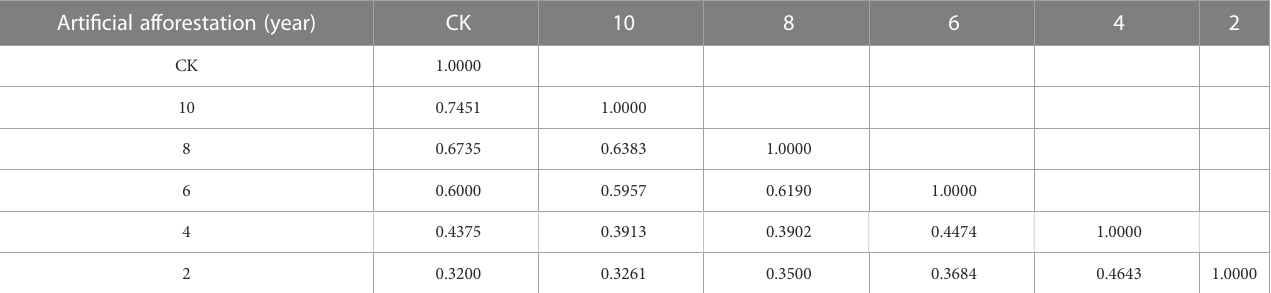
TABLE 4 Similarity coef fi cient of grassland plant community with different years of arti fi cial afforestation in Maxian Mountain of the Loess Plateau. Arti fi cial afforestation (year)